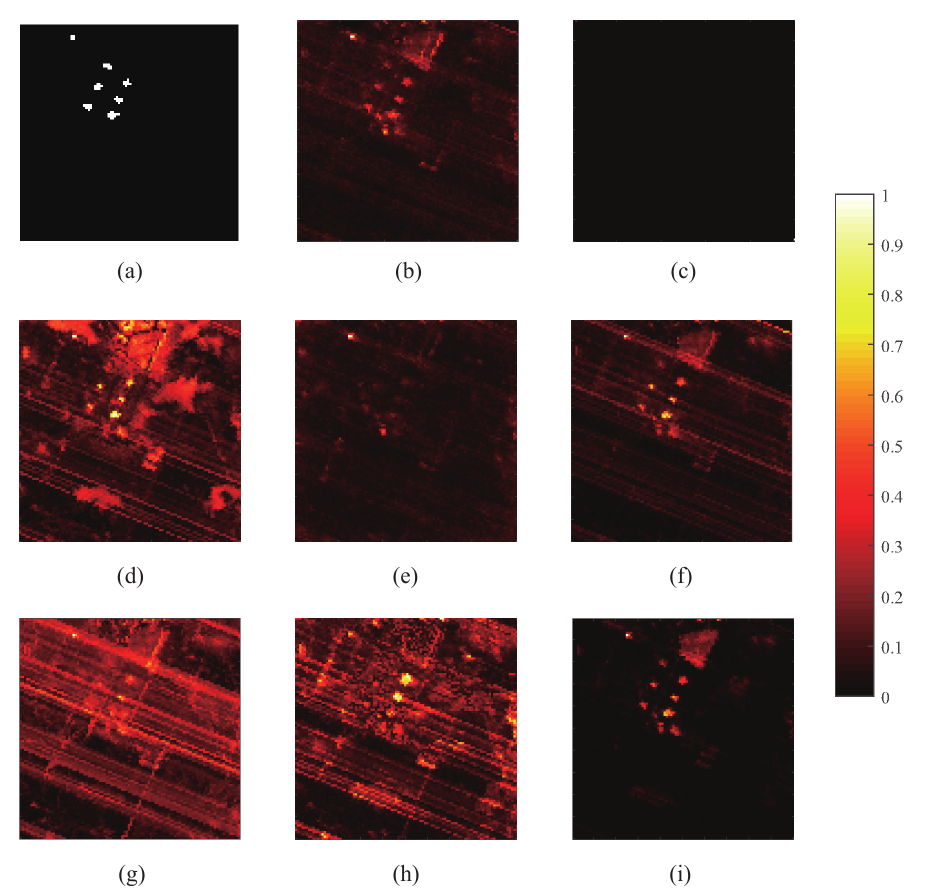
Figure 9. The detection maps of different algorithms for the Texas Coast urban dataset, the parameters in brackets are sizes of double-window used in corresponding algorithms. ( a ) Reference map. ( b ) GRX. ( c ) LRX (5, 29). ( d ) BJSR (3, 23). ( e ) CRD (3, 23). ( f ) LSMAD. ( g ) LRASR. ( h ) KIFD. ( i ) LCLRR.